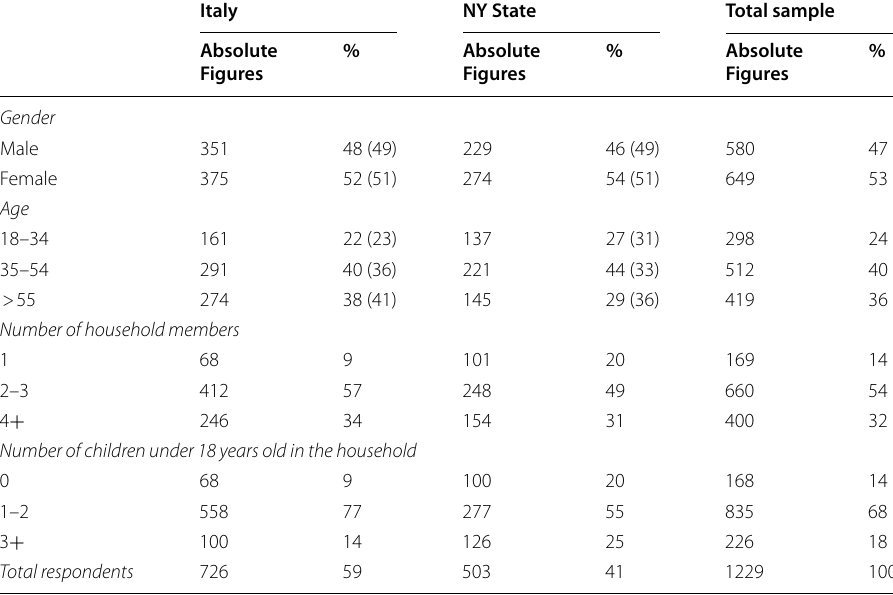
Table 1 Demographic characteristics of our